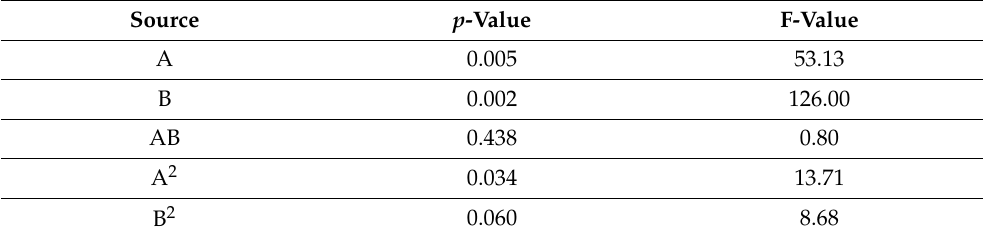
Table 2. Analysis of variance. Table 3. Analysis of variance after removing non-significant factors.